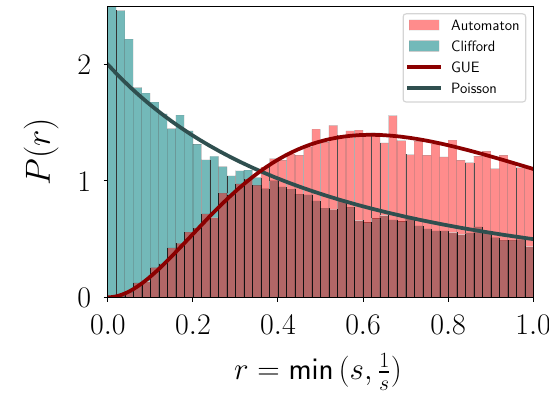
FIG. 5. The level spacing distribution of the entanglement spectrum for automaton wave functions show Wigner-Dyson GUE statistics, while the Clifford states show Poisson-like statis- tics. Wigner-Dyson statistics are expected for the eigenvalue distribution of random matrices and are a signature of quantum